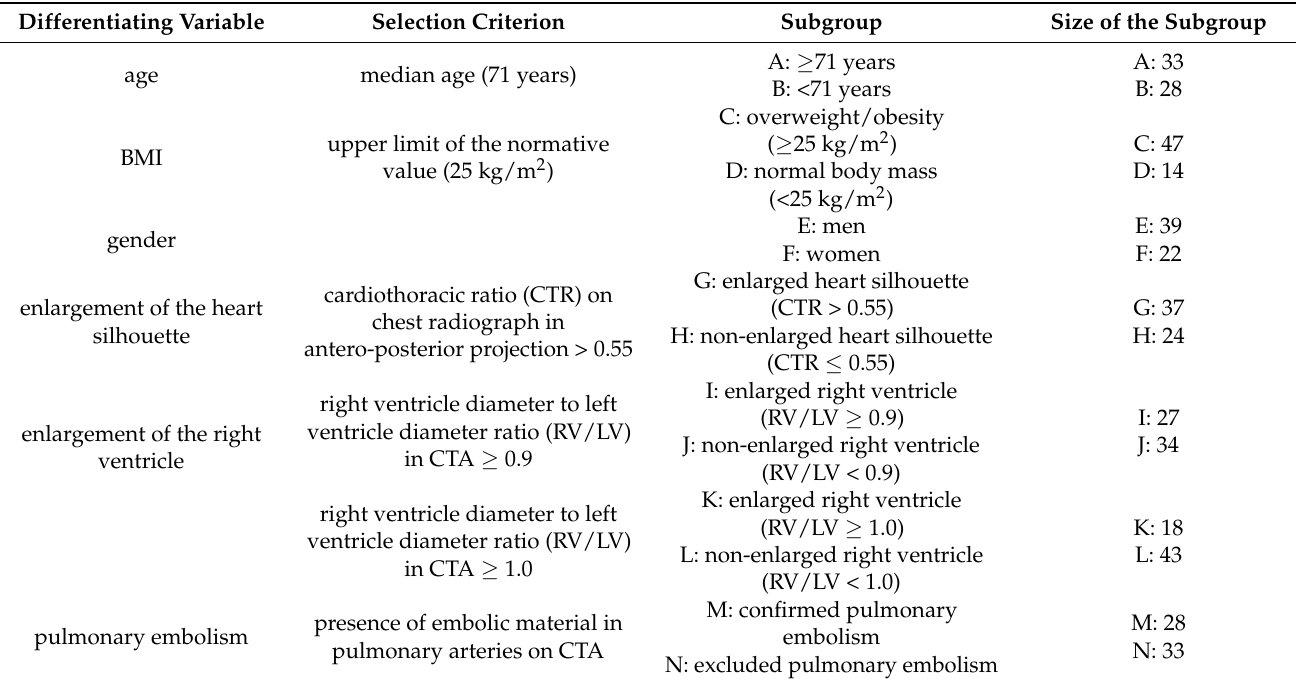
Table 2. Criteria for distinguishing the study